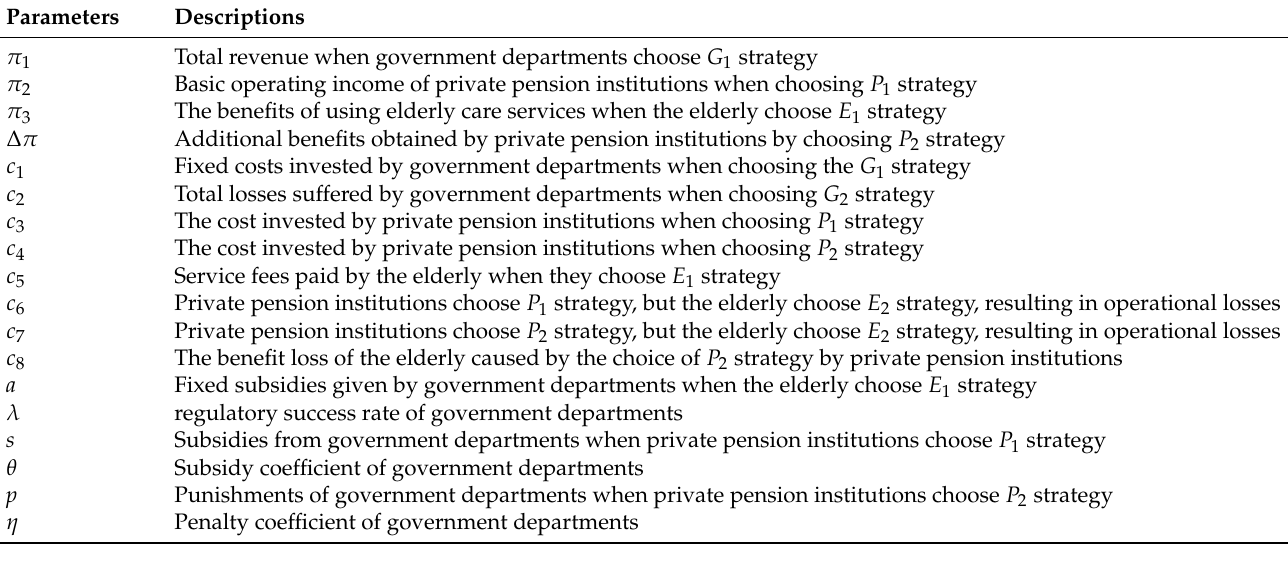
Table 1. Parameters and